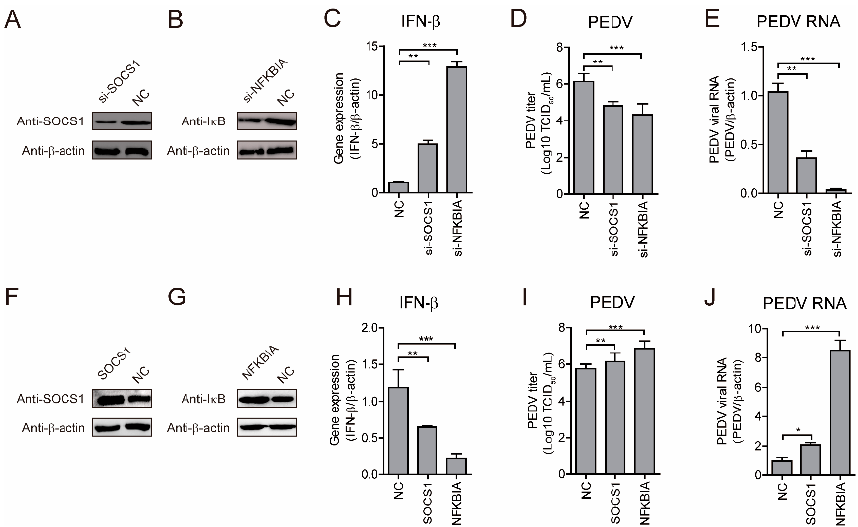
Figure 8. NFKBIA and SOCS1 suppress IFN- β expression to promote PEDV replication. ( A – E ) MARC- 145 cells were transfected with siRNA control (NC), si-NFKBIA, or si-SOCS1 for 48 h and infected with PEDV CH/HBTS/2017 at an MOI of 0.1 for 24 h. ( A , B ) Western blot confirmed the knockdown of SOCS1 and I κ B. ( F – J ) MARC-145 cells were transfected with Flag control (NC), Flag-NFKBIA, or Flag-SOCS1 for 48 h, and infected with PEDV CH/HBTS/2017 at an MOI of 0.1 for 24 h. ( F , G ) confirmed the overexpression of SOCS1 and I κ B. ( C , H ) Real-time qRT-PCR analysis of IFN- β expression (normalized to β -actin expression). ( D , I ) TCID 50 analysis of viral titers. ( E , J ) Real-time qRT- PCR analysis of intracellular levels of viral genomic RNA (normalized to β -actin expression). ( A – F ) Data represent the mean ± SD of three independent experiments and measured in technical duplicate. Comparisons between groups were determined by Student’s t test. * p < 0.05; ** p < 0.01; *** p < 0.001.